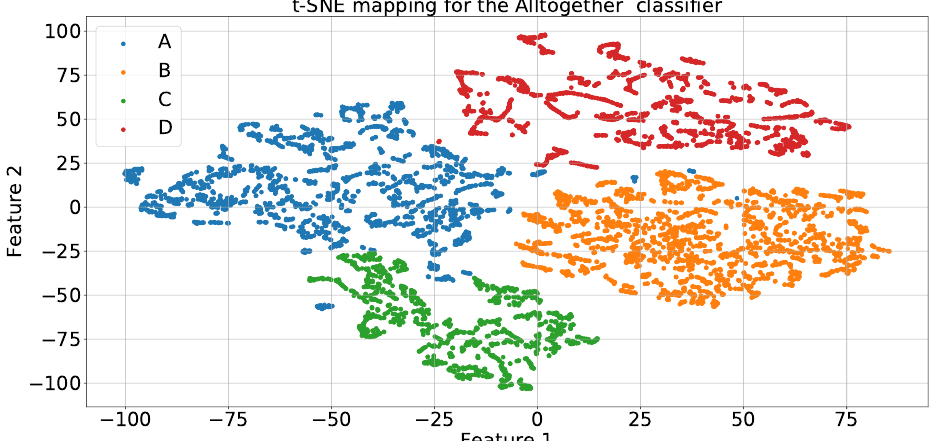
Figure 22. t-SNE visualization of the second to last layer output for the all together classifier in the LORO scenario for the MaxPro